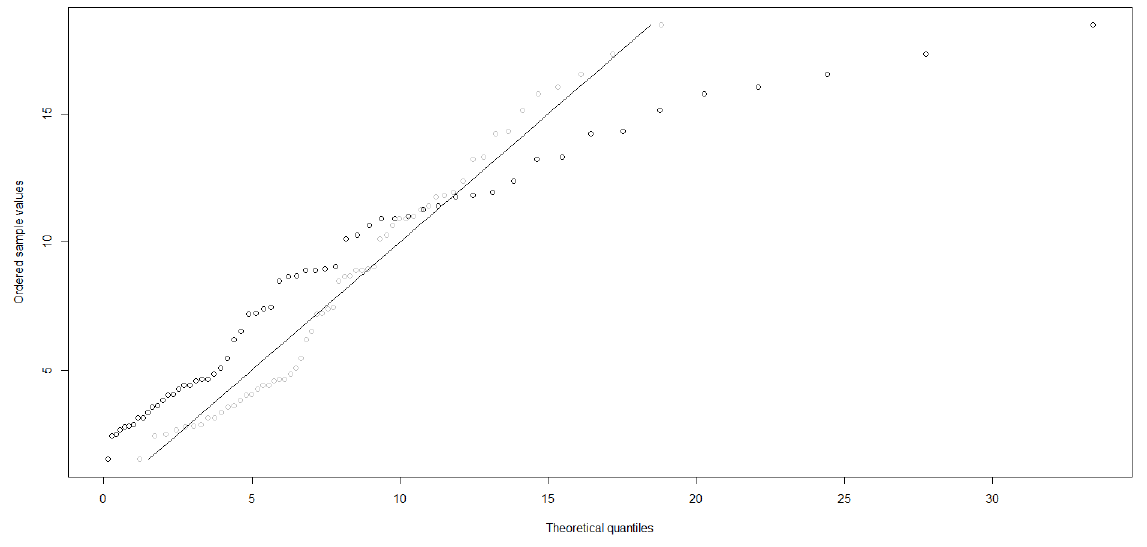
Figure 3. Probability plot of a fitted Rayleigh (grey dots) and exponential (black dots) distribution.